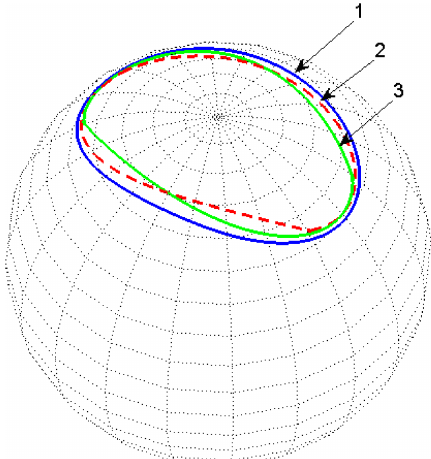
Figure 4. Spherical base curve of tooth profile curve of second or- der elliptic bevel gear. 1 – Pitch curve. 2 – Spherical base curve of right tooth profile. 3 – Spherical base curve of left tooth